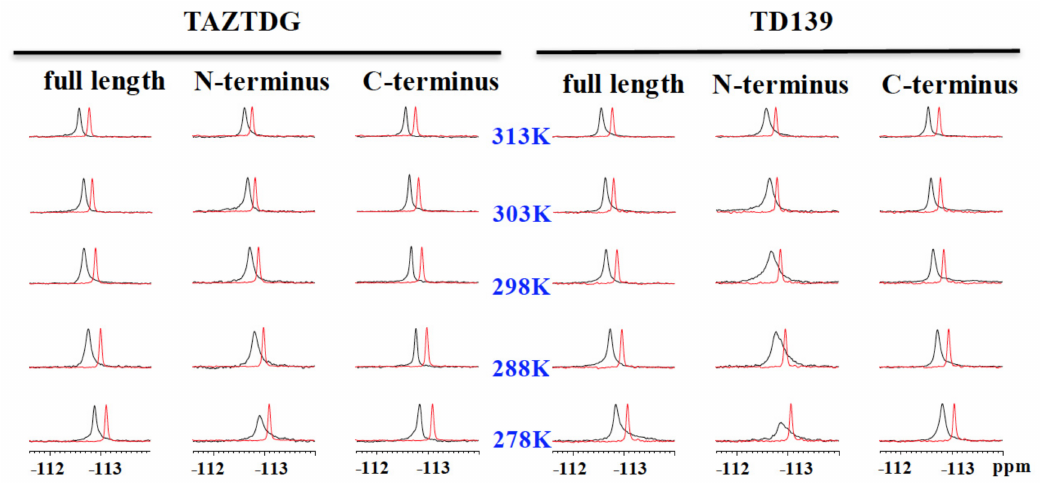
Figure 15. The 19 F-NMR spectra of TAZTDG (left panel) and TD139 (right panel) in complex with GAL-8 full , GAL-8 NCRD , and GAL-8 CCRD are shown in the order of decreasing temperatures (from top to bottom). The spectra of free TAZTDG and TD139 under the same conditions are shown in red as